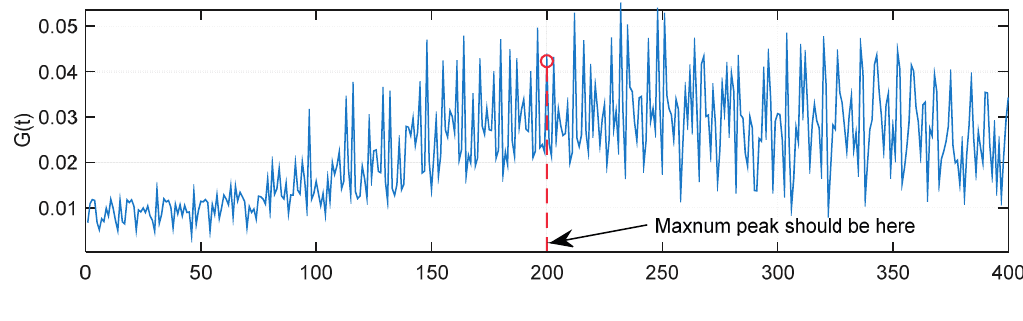
Figure 8. G ( t ) with E b / N 0 = − 10